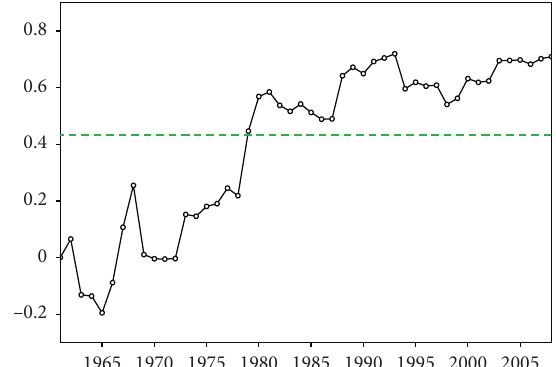
Figure 5: Evolution of 21-year slide correlation coefficients be- tween the JJA precipitation in the western mountainous region and the prewinter Niño3 SST. The green dashed line denotes the sig- nificant correlation coefficient at 95% confidence